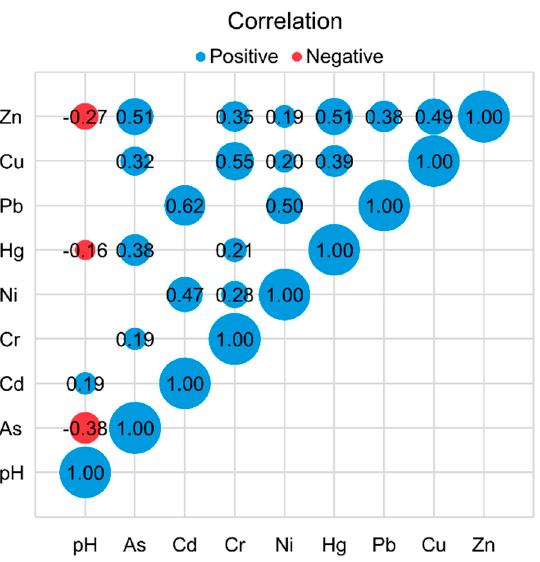
Figure 4. The correlations between heavy metals by combining Pearson correlation analysis (no significance had not been shown).